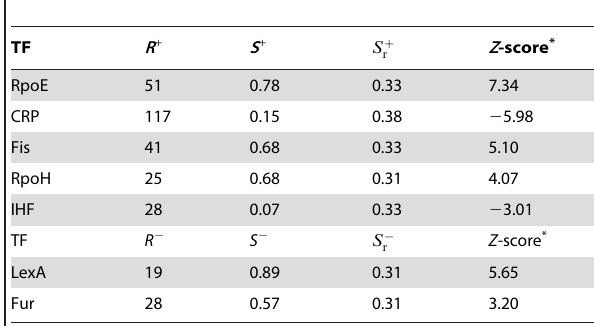
Table 2. Positive and negative